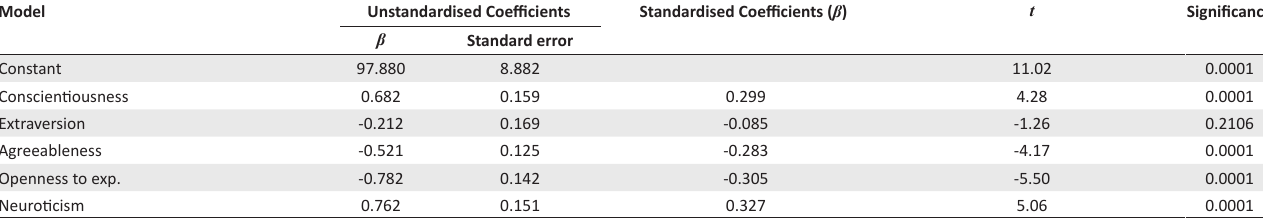
TABLE 5: Coefficients showing the relative contribution of each of the dimensions of big five factors in predicting job crafting. Model Unstandardised